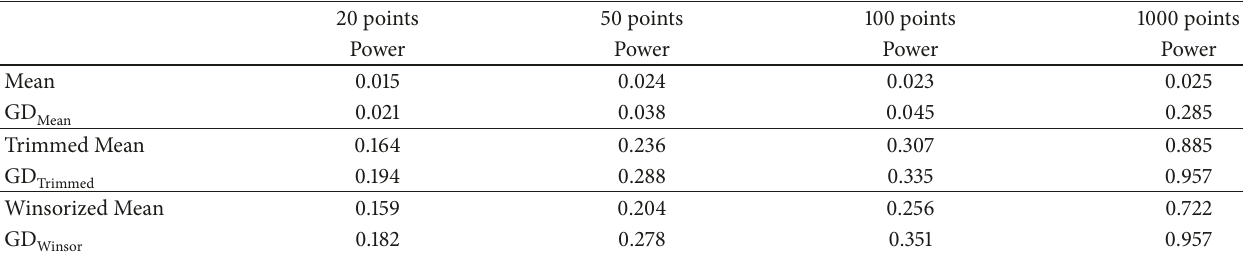
Table 8: The values of power for a log normal distribution of parameters 𝑥 = 2 and 𝑠 = 1 and 30 % of Gaussian noise. The level of noise is expressed as percentage of the mean of the distributions. In the columns we have reported the values of the Power obtained with the GDGM methods compared to conventional methods. The distributions are composed with 20, 50, 100, and 1000 points.